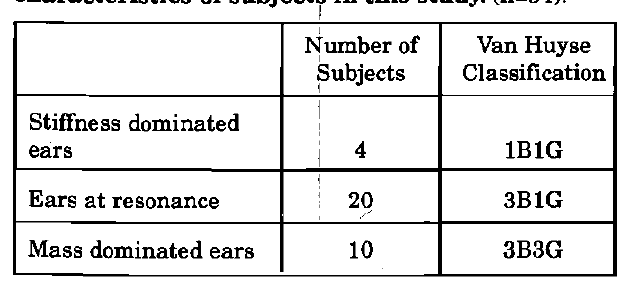
TABLE 3: Results of the phasor analysis of growth functions obtained for 500 and 1000 Hz stimuli (n = 68).